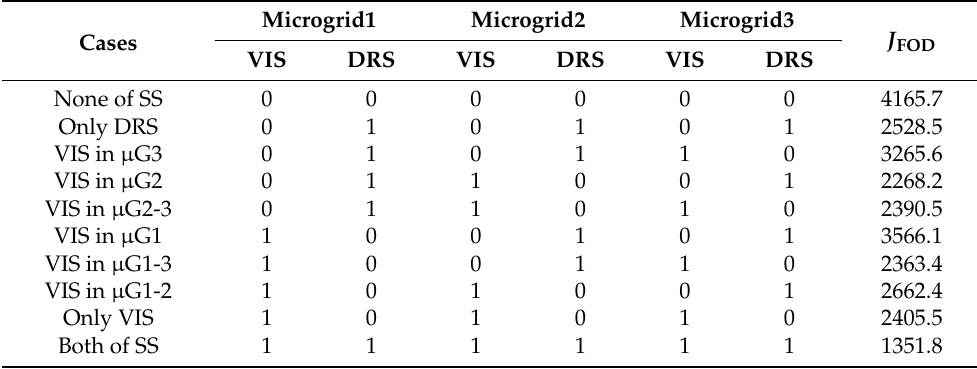
Table 6. Optimal allocation of DRS and VIS